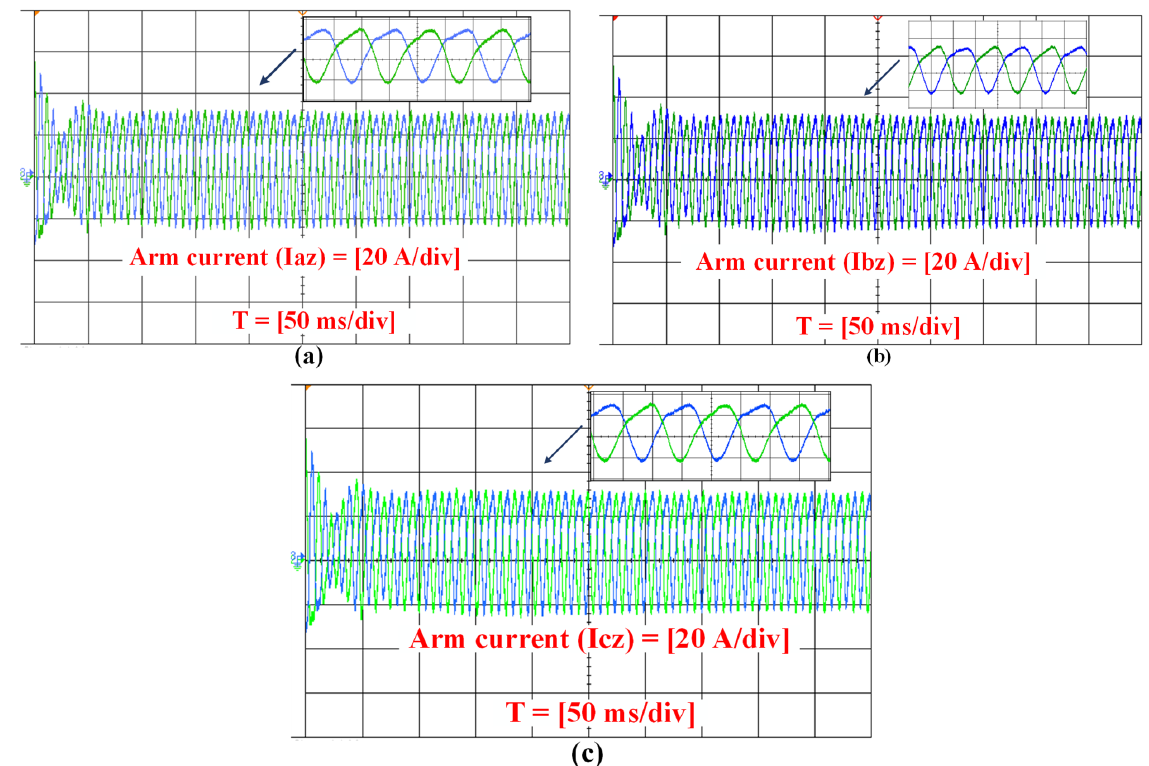
Figure 19. ( a ) Arm currents of each phase i az in MMC, ( b ) arm currents of each phase i bz in MMC, and ( c ) arm currents of each phase i cz in MMC.